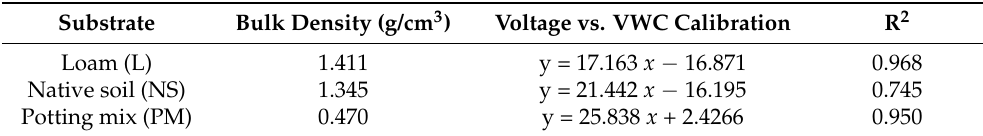
Table 2. Bulk density and substrate VWC calibration equation. Substrate Bulk Density (g/cm 3 ) Loam (L) Native soil (NS) Potting mix